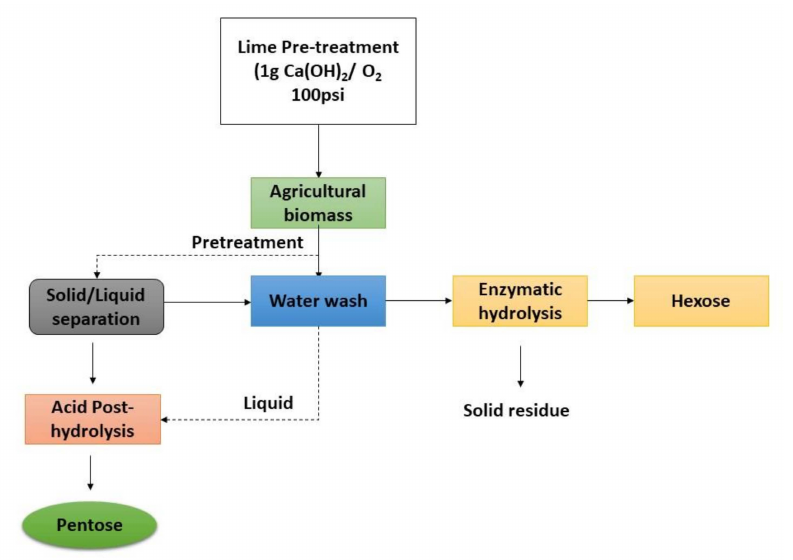
Figure 4. Schematic representation of agricultural biomass pretreatment using lime (Ca(OH) 2